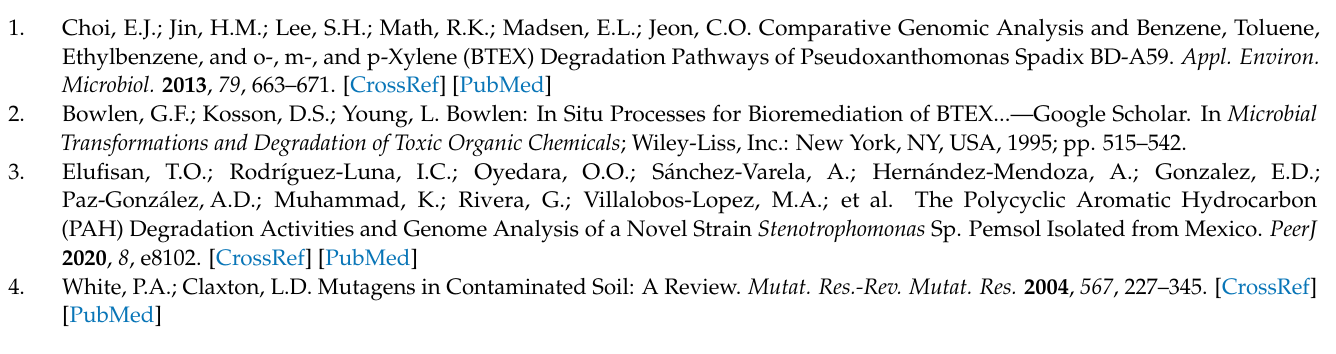
Figure S3: Gene region in Sphingobium yanoikuyae S72 that are associated with PAH degradation and showing hypothetical genes that may also be helping in the degradation of PAH; Table S1: COG comparison between S72 and other PAH degrading bacteria retrieved from the IMG database; Table S2: List of genes in Sphingobium yanoikuyae S72 which is associated with the degradation of